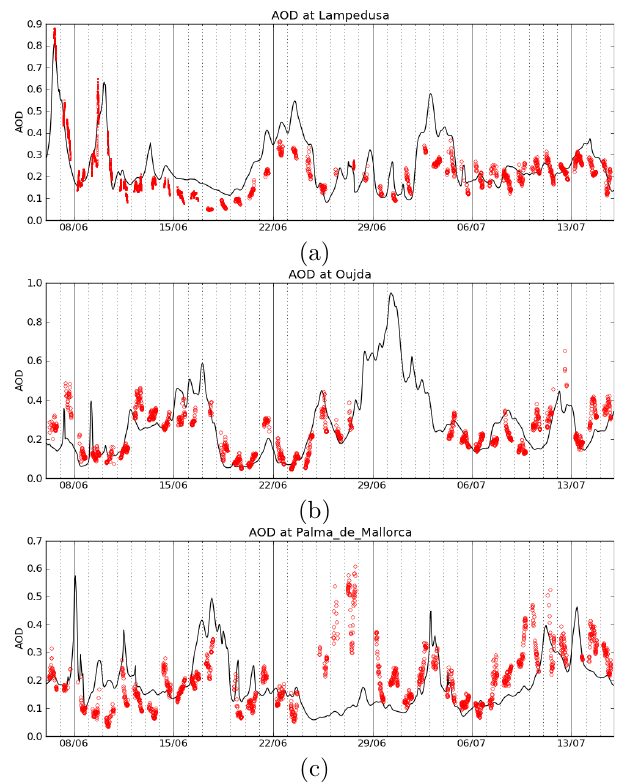
Figure 7. Evolution of modelled AOD (black lines) at 400nm above Lampedusa, Oujda and Palma de Mallorca compared to the AERONET AOD interpolated at 400nm (red circles). For Lampe- dusa, AERONET data are completed with MFRSR data (red dots) when the AERONET data were not